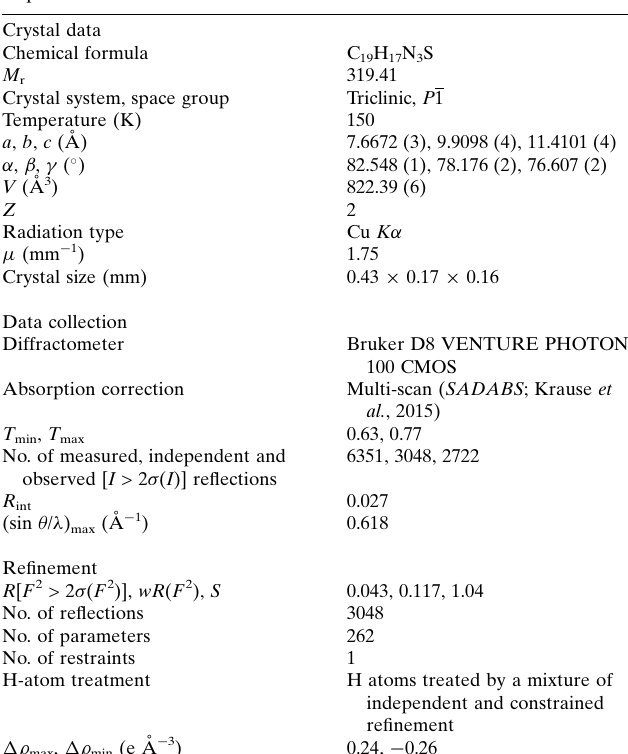
Table 2 Experimental